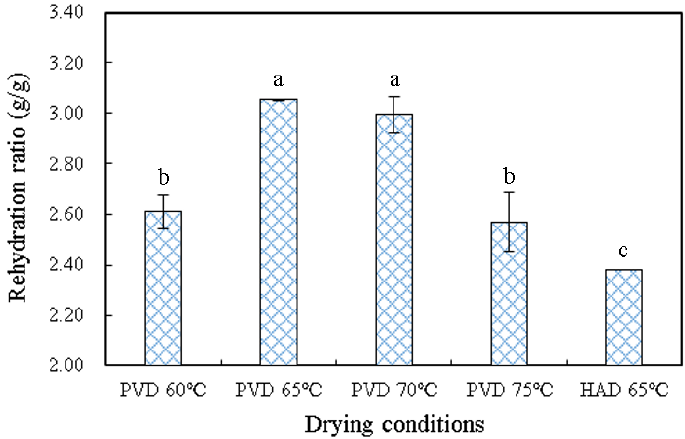
Figure 4. Rehydration ratio of persimmon slices under different drying conditions. PVD: pulsed vacuum drying (12:4 min). HAD: hot air drying. The different letters, a, b, and c, reveal significant differences ( p < 0.05) according to the Duncan test.